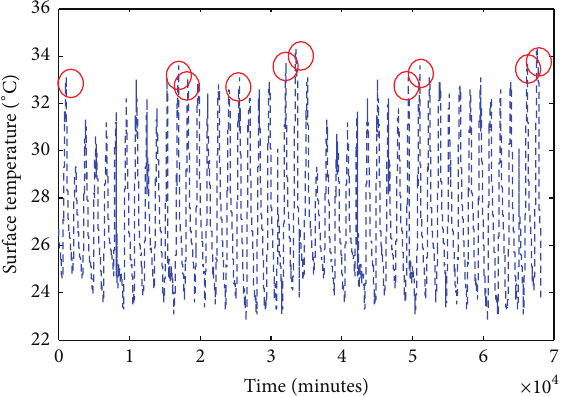
Figure 4: Ten-year surface temperature data